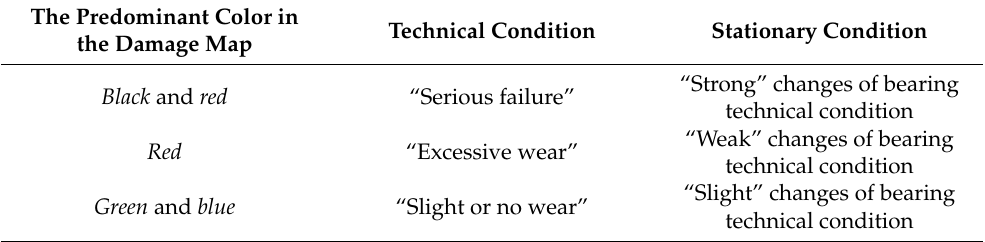
Table 1. Legend for the damage maps. The Predominant Color